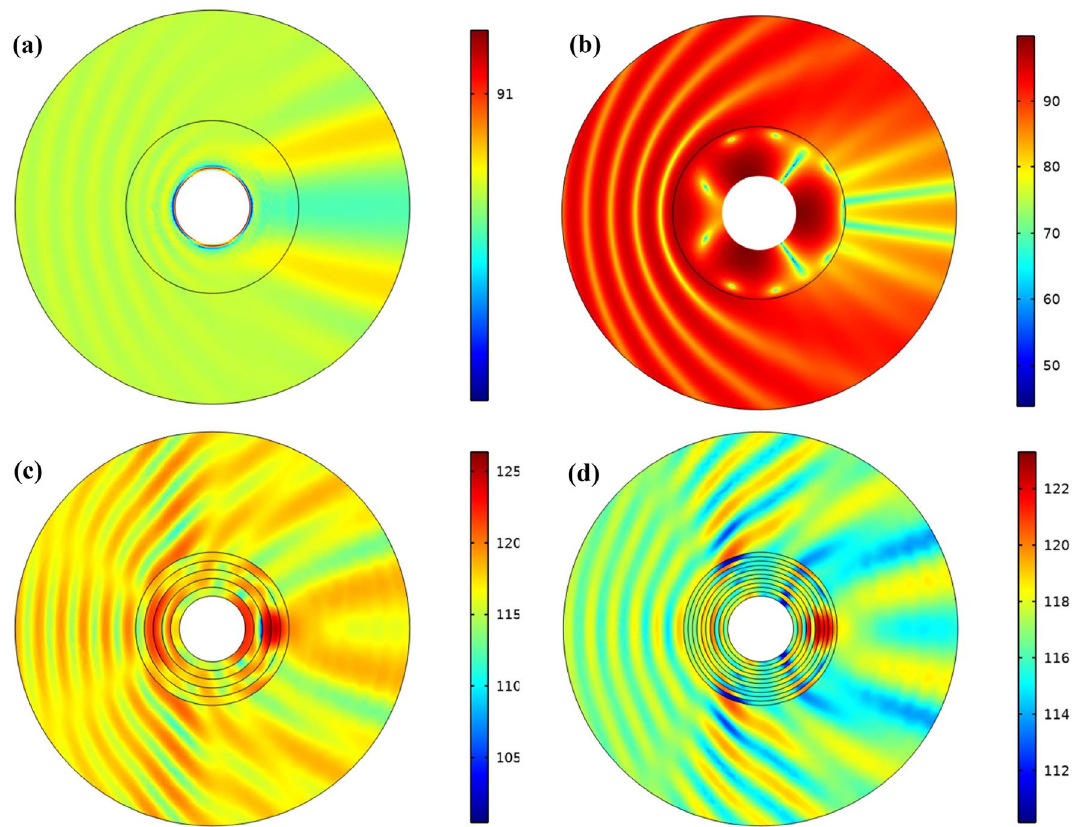
Figure 3. The total sound pressure level for ( a ) homogeneous cloak structure with anisotropic materials, ( b ) no cloak structure and multi-layers cloaking structure with ( c ) 5 layer and ( d ) 10